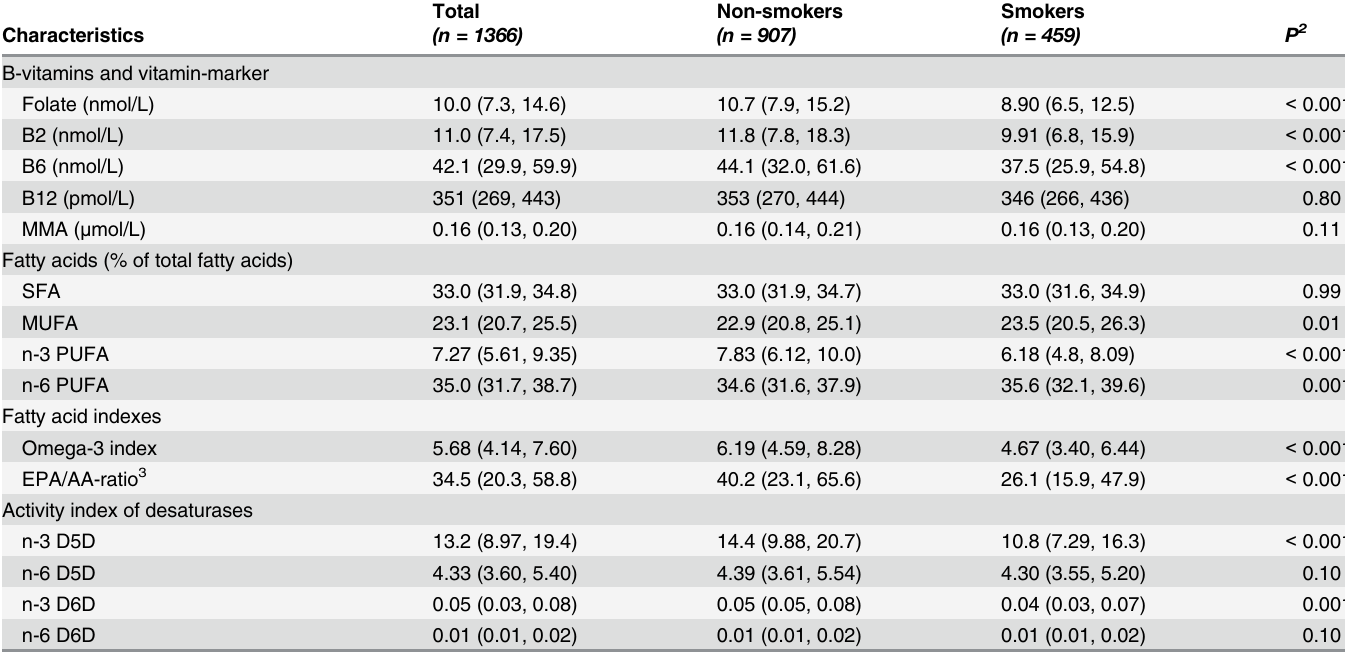
Table 3. Serum/plasma concentrations of vitamins, subgroups of fatty acids, fatty acid indexes and activity index of desaturases according to smoking status 1